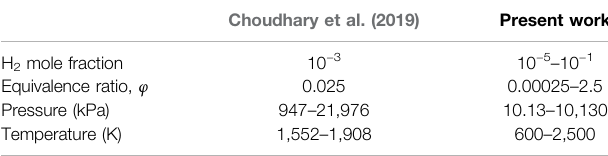
TABLE 1 | Mixture conditions. The balance gas is nitrogen.